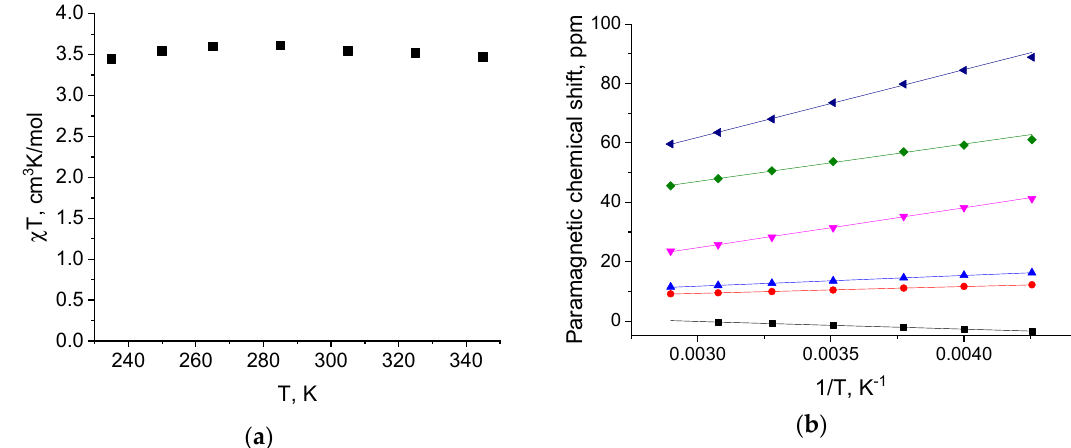
Figure 6. ( a ) Variable-temperature magnetic susceptibility data for the solution of [Fe( L ) 2 ](BF 4 ) 2 in acetonitrile-d 3 according to the Evans method, and ( b ) paramagnetic chemical shifts plotted versus 1 / T (bottom); the lines represent the linear fit over the entire temperature range 250–345 K.